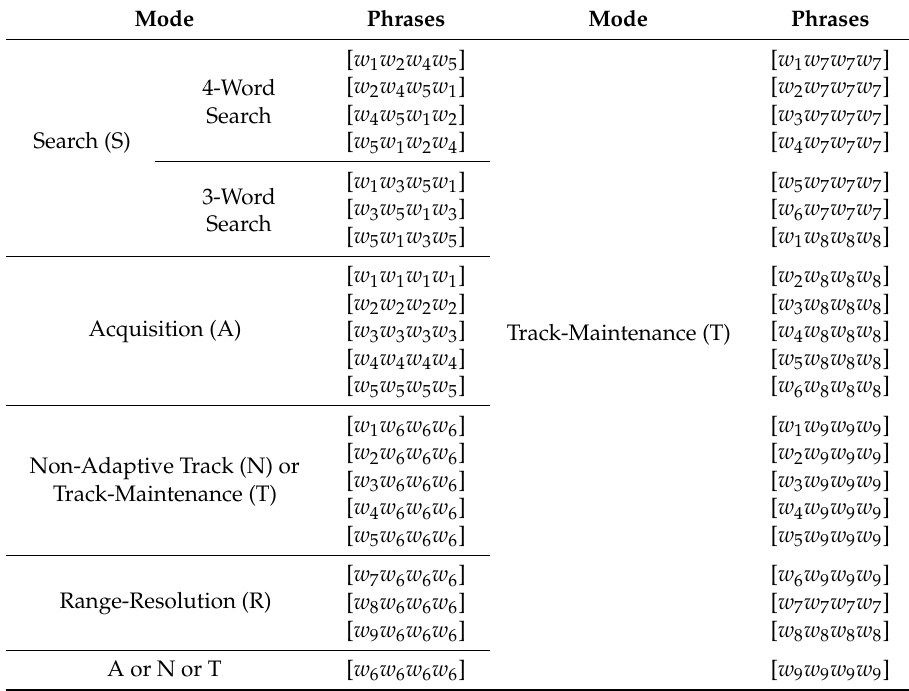
Table 1. Phrases of the “Mercury” radar for each operating mode.